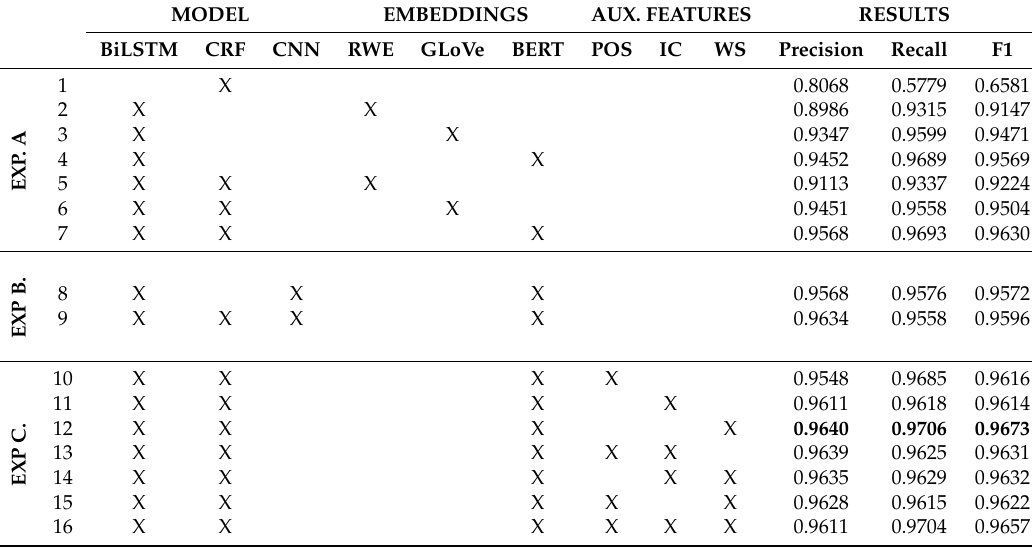
Table 2. Model variations and performance metrics of the experiments. (Top Section): Conditional Random Fields (CRF) layer and embeddings combination results. (Middle Section): Character embeddings model extension experiment results. (Bottom Section): Auxiliary features variations experiment